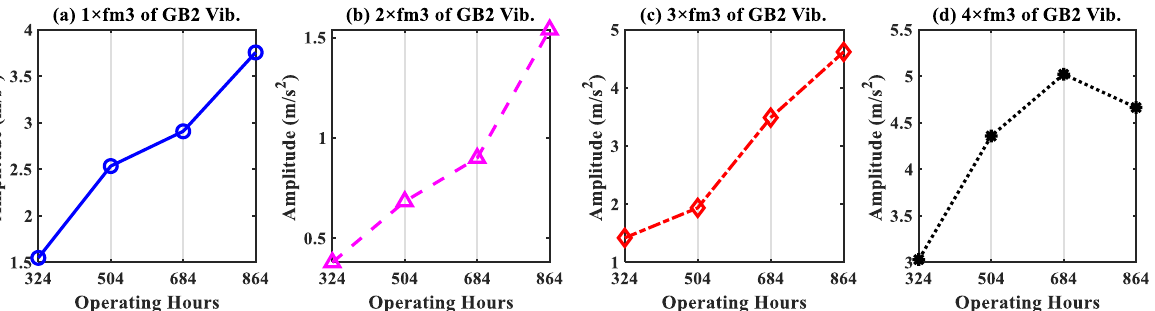
Figure 18. Amplitudes of 𝑓 m3 and its harmonics in the TSA spectrum. ( a ) Amplitude of the first harmonic 1 × f m3 ; ( b ) Amplitude of the second harmonic 2 × f m3 ; ( c ) Amplitude of the third harmonic 3 × f m3 ; ( d ) Amplitude of the fourth harmonic 4 × f m3 .